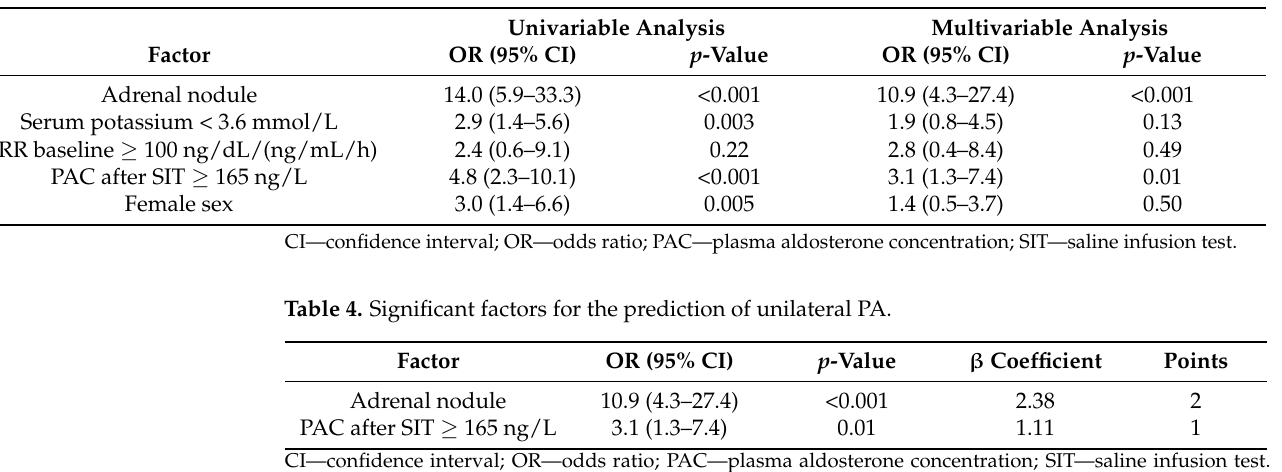
Table 3. Candidate factors for the prediction of unilateral PA (univariable and multivariable logistic regression analysis).